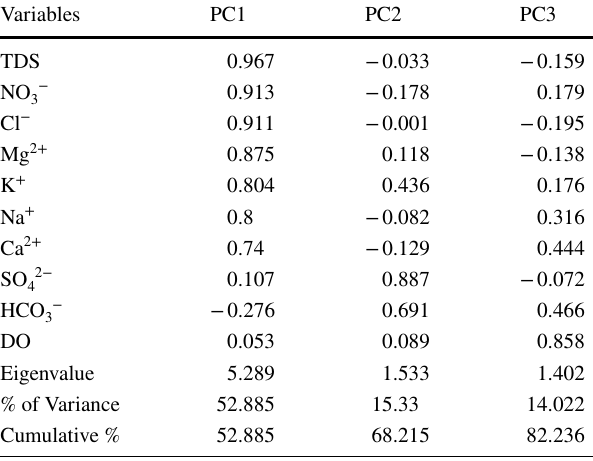
Table 3 Component loadings, eigenvalues and total variance of the two extracted components after varimax